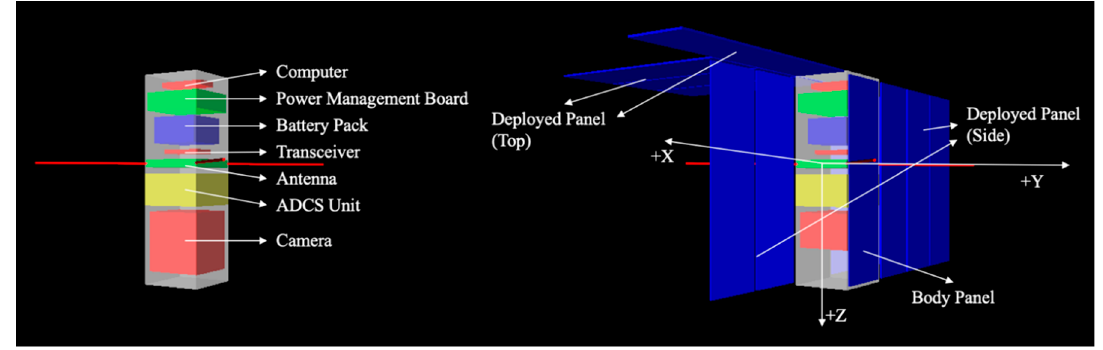
Figure 3. Example of a phenotype of the CubeSat genotype rendered in MATLAB VRML.